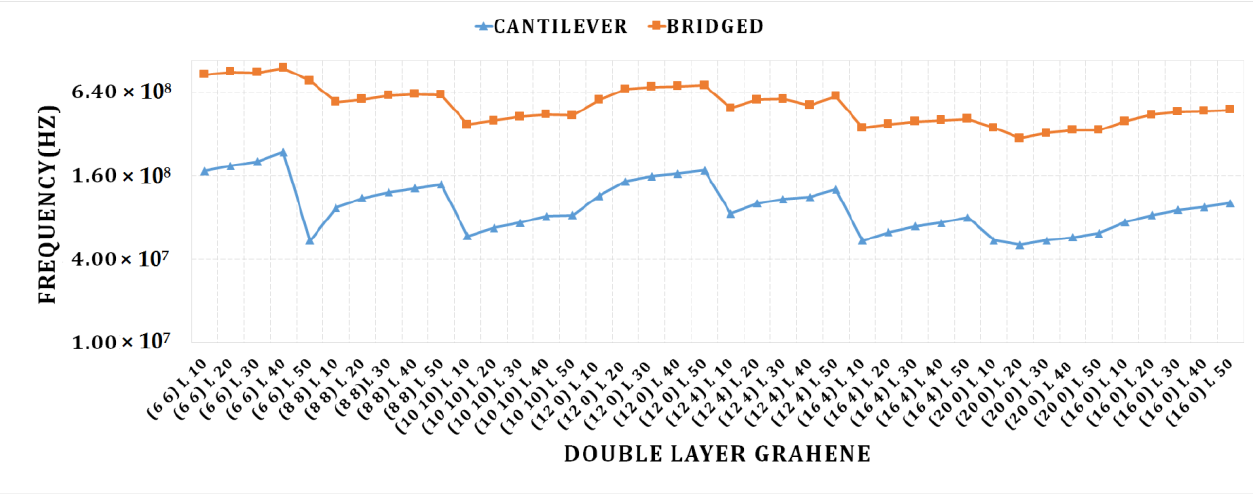
Figure 6. Cantilever and bridged DLGs; graph for different length and chirality vs. frequency.